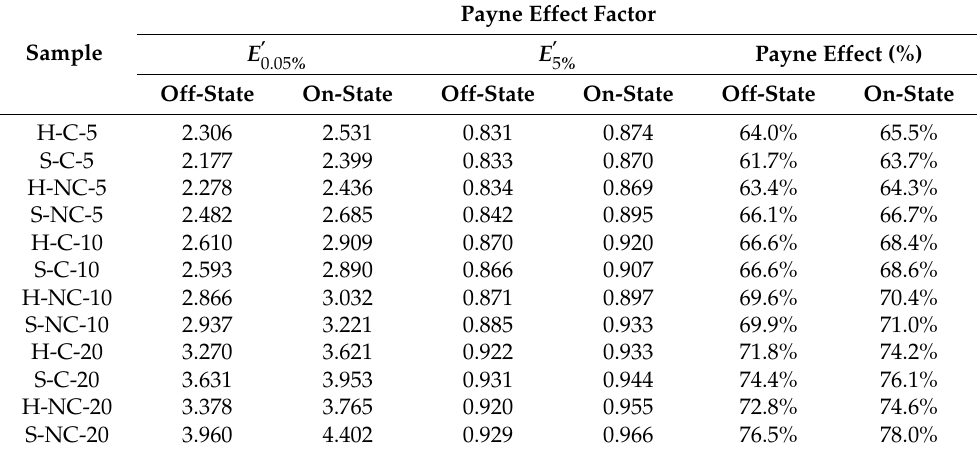
Table 4. The initial and final storage modulus and the Payne effect factor for the measured samples.